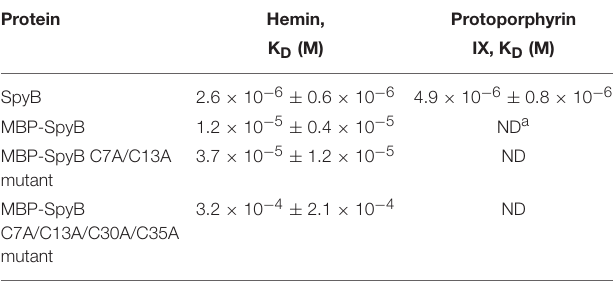
TABLE 2 | Hemin and protoporphyrin IX binding constants for SpyB protein